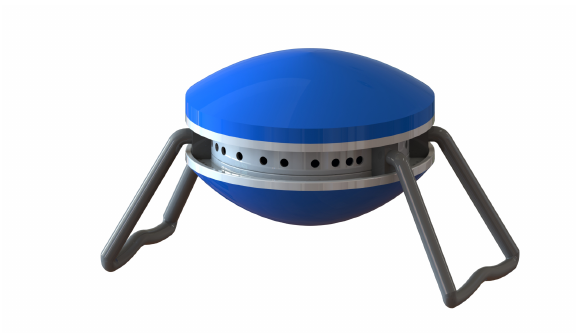
Figure 5: Description of the cover systems used for the drone.